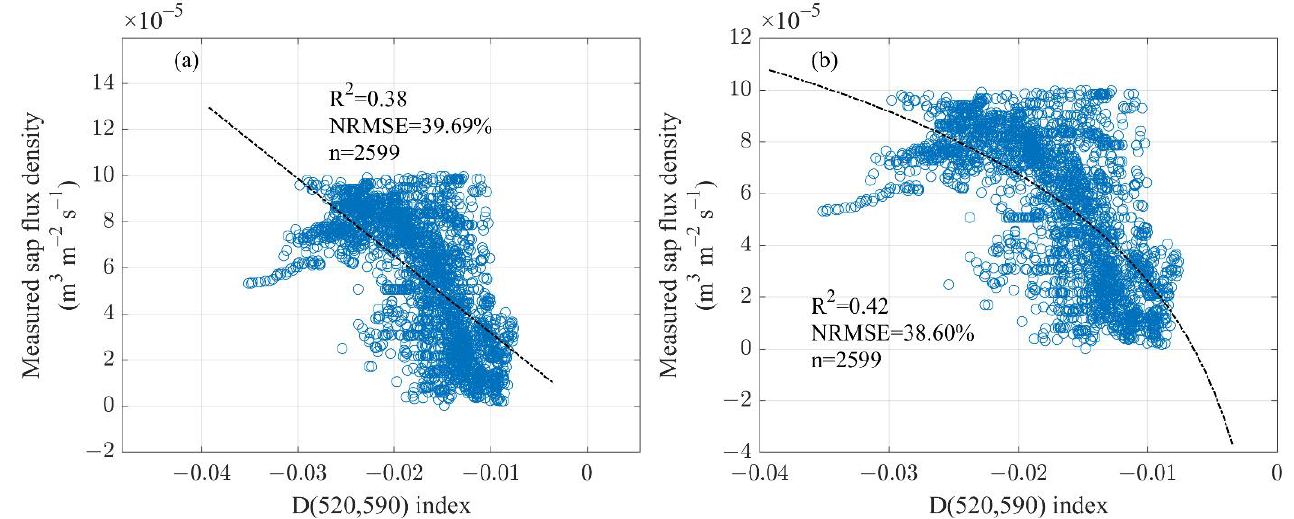
Figure 4. The relationship between the D(520, 590) index based on reflectance and the measured sap flux density with Grainer sensors. The black dashed line is the regression line ( a ) fitted with a polynomial regression (linear to the first order), ( b ) fitted with a natural logarithmic function.